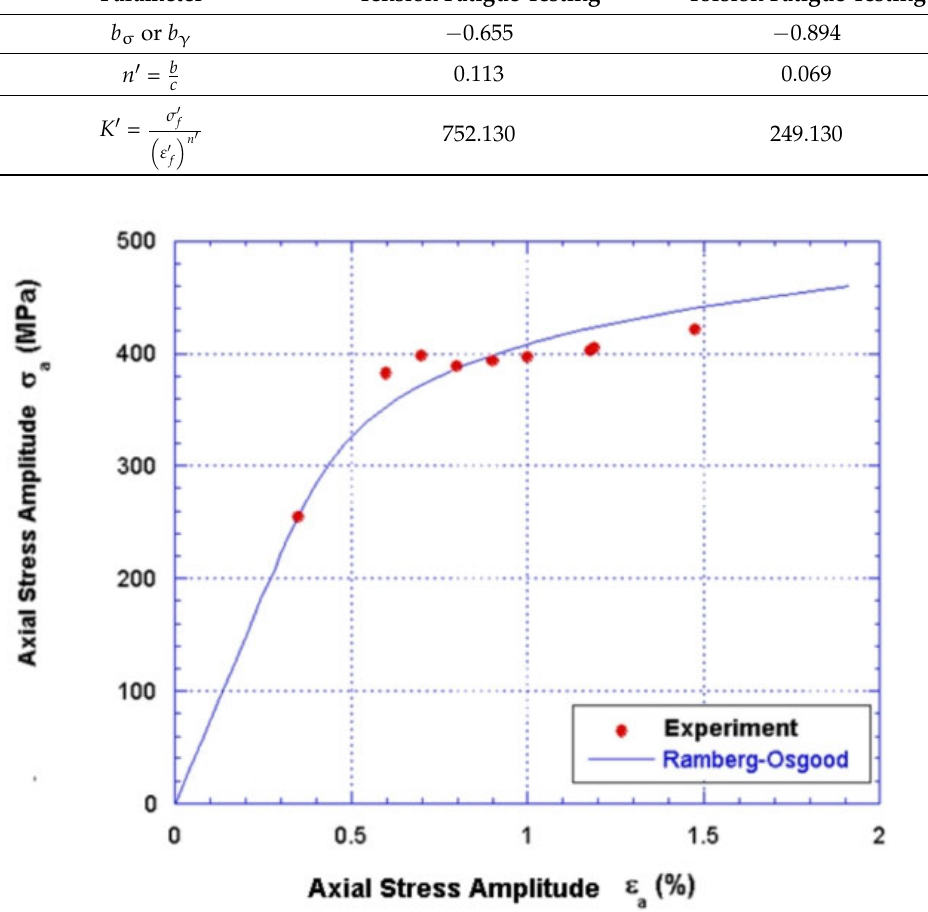
Figure 6. Dynamic stress–strain diagram for AlMgSi1.